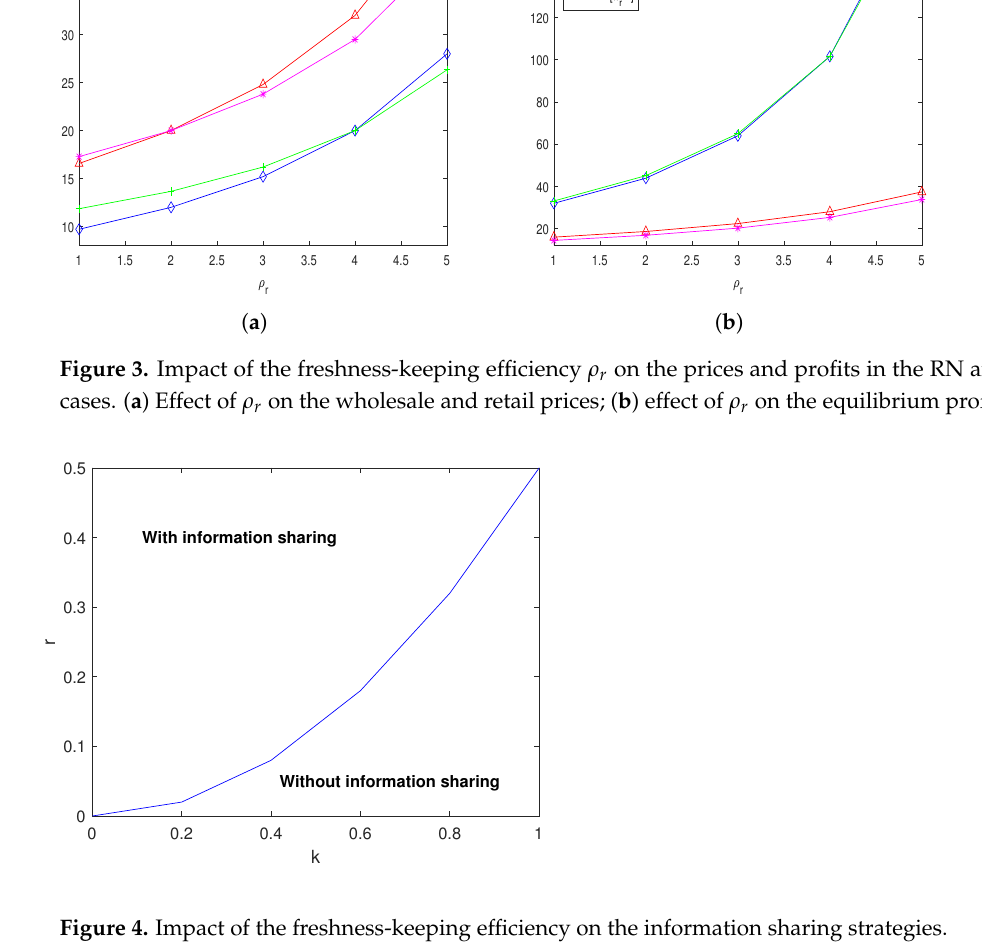
Figure 4. Impact of the freshness-keeping efficiency on the information sharing